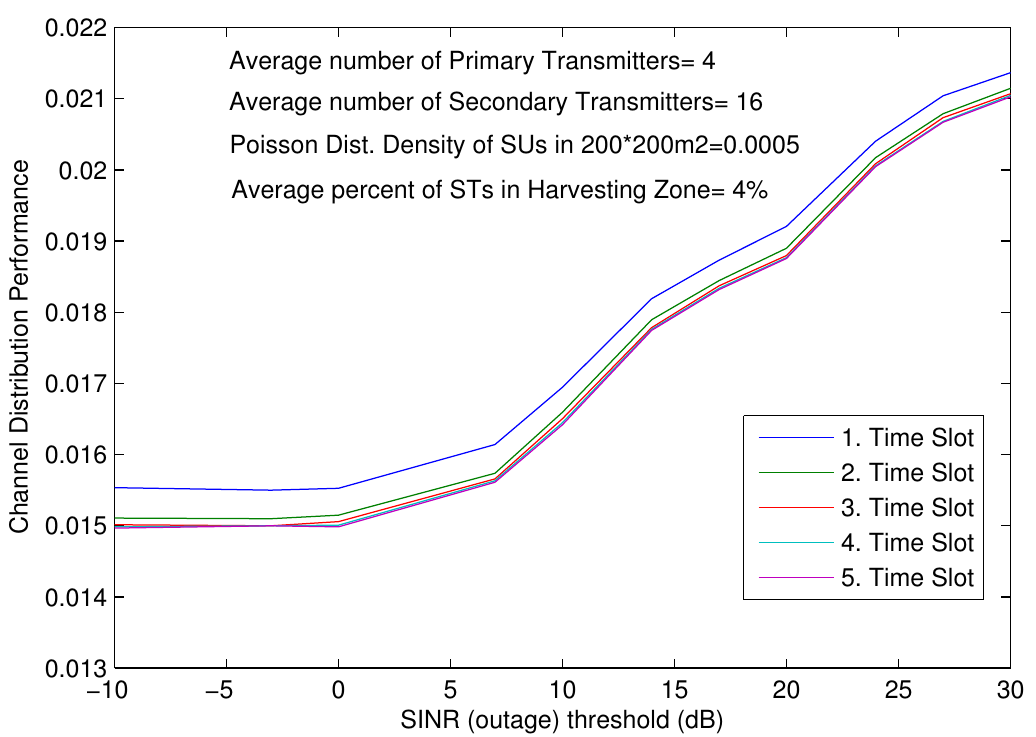
Figure 5. ChDistFairness against different SINR (threshold) values for Poisson distribution density of STs of 0.0005 in a 200 × 200 m 2 area around the PT and average percentage of STs in harvesting zone of about